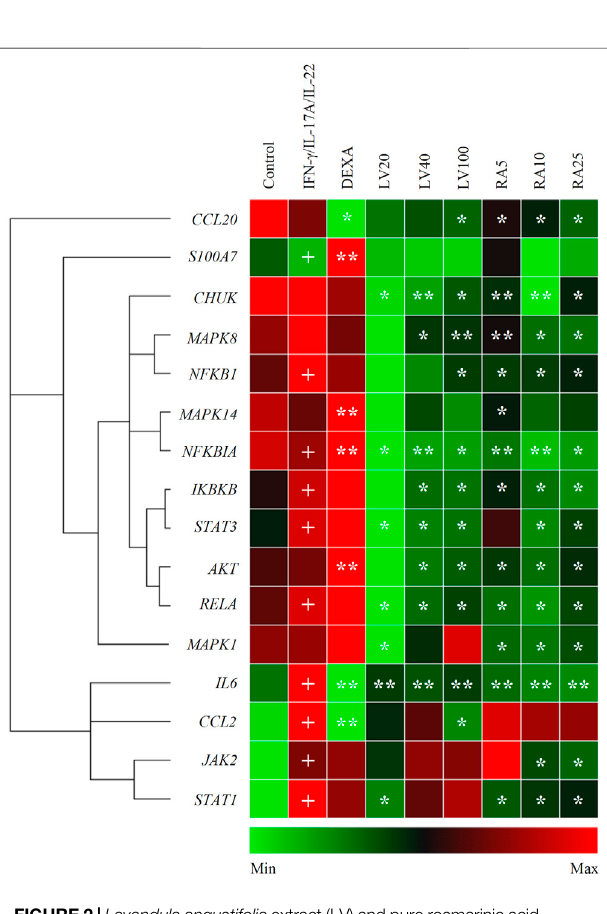
FIGURE 2 | Lavandula angustifolia extract (LV) and pure rosmarinic acid (RA) downregulate in fl ammatory gene expression in psoriasis-like model in human keratinocytes. Clustergram and heatmap of the relative gene expression analysis from the RT-qPCR. The results are expressed as mean ± SEM from three independent experiments. + p < 0.05 compared to control cells; * p < 0.05 and ** p < 0.01 com-pared to psoriasis-like model